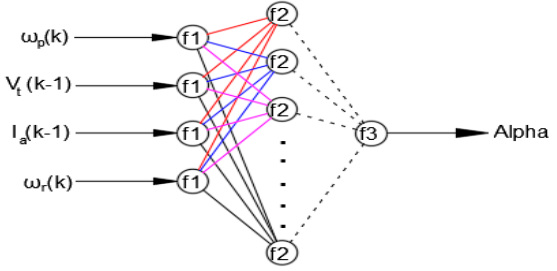
Figure 22. Basic ANN structure consisted of 3 layers [45].